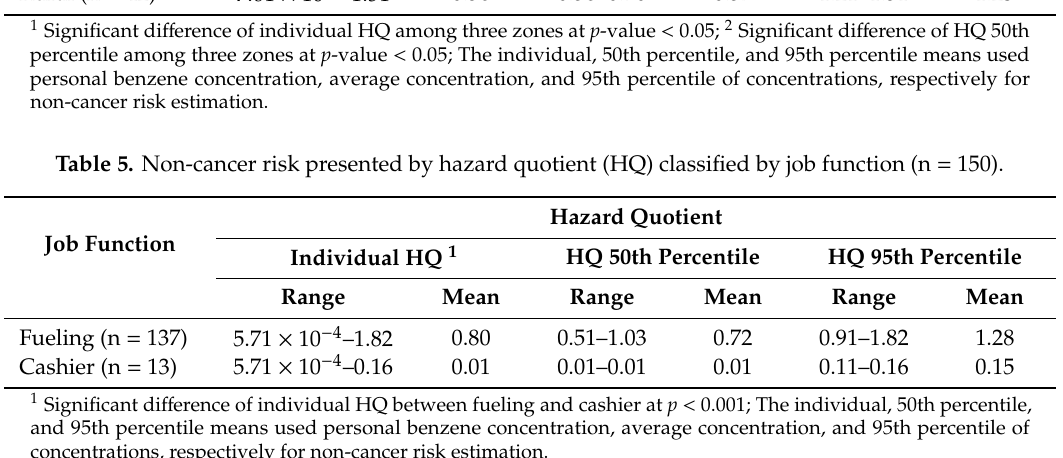
Table 4. Non-cancer risk presented by hazard quotient (HQ) classified by zone (n = 150). Hazard Quotient Zone Individual HQ 1 HQ 50th Percentile 2 HQ 95th Percentile Range Mean Range Mean Range Mean Urban (n = 48) 5.71 × 10 − 4 1.82 0.61 0.43–0.86 0.59 0.91–1.82 1.24 Suburban (n = 60) 5.71 × 10 − 4 1.82 0.96 0.65–1.29